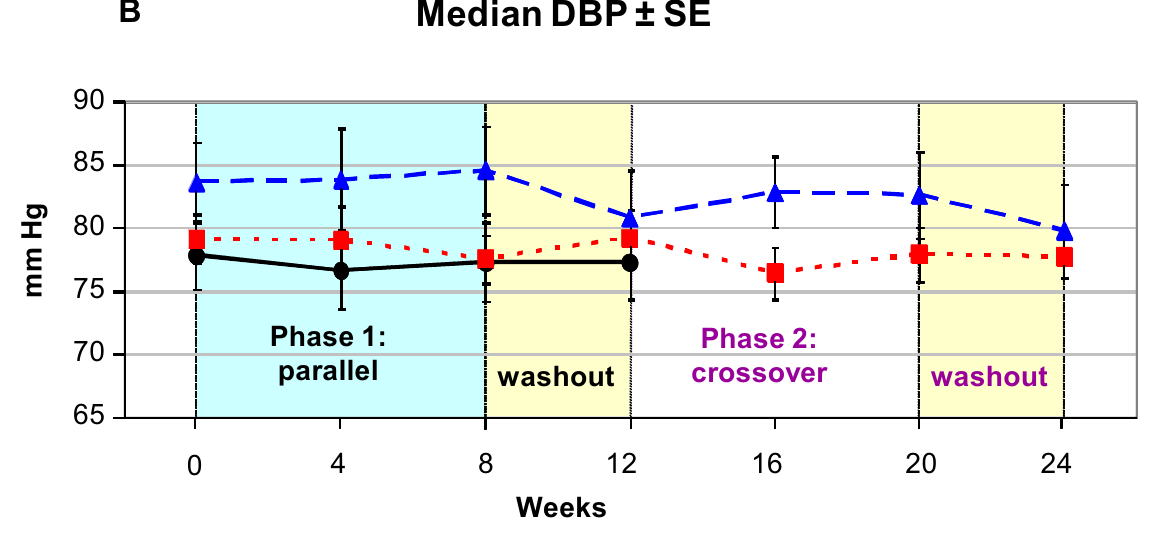
Median systolic (A) and diastolic (B) blood pressure ± standard error (SE), during phase 1 (three group parallel RCT, 12 weeks) and phase 2 (crossover of active treatment groups, 12 weeks)